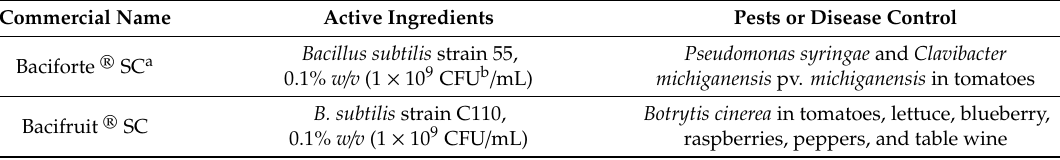
Table 4 lists some formulations authorized for use in organic farming to control disease. Table 4. Some biopesticides based on microorganisms authorized in organic